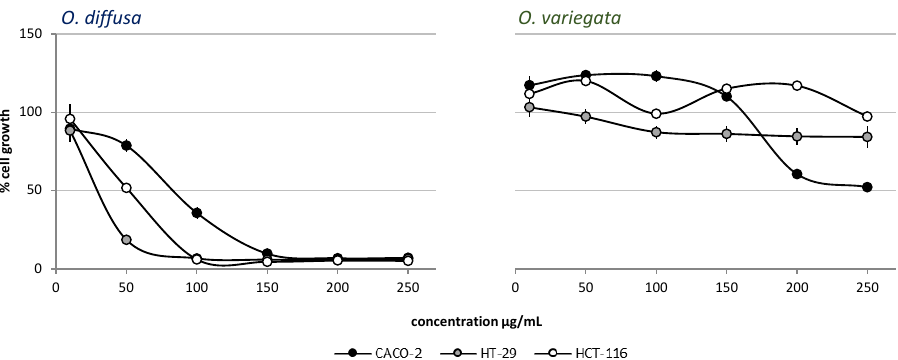
Figure 1. Antiproliferative activity evaluation of O. diffusa and O. variegata on the Caco-2, HT-29, and HCT-116 cell lines. Cell growth is expressed as percentage from control, and is plotted on the vertical axis, while doses of plant extracts are reported on the horizontal axis.